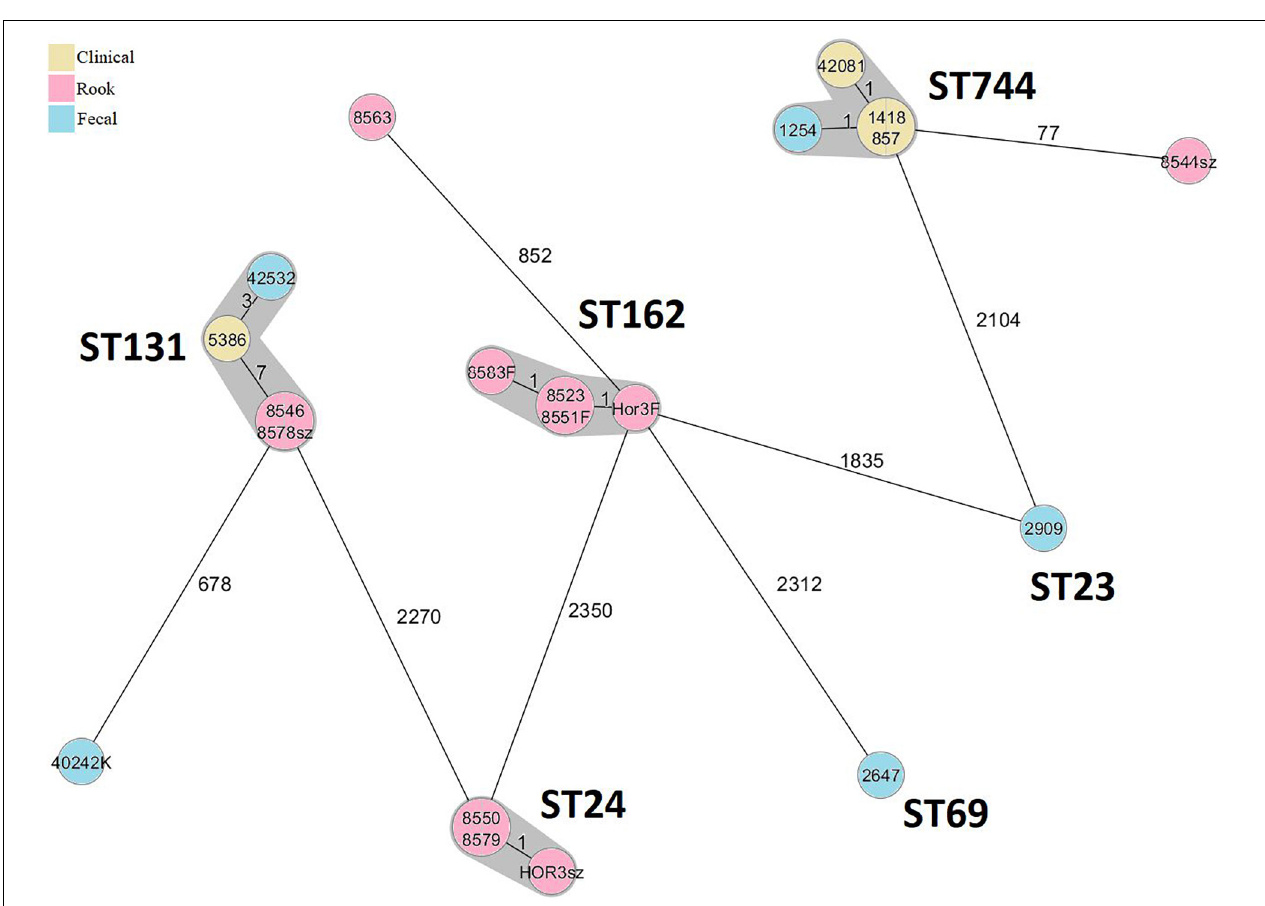
FIGURE 1 | Minimum spanning tree based on cgMLST allelic profiles of 20 sequenced E. coli isolates. Each circle represents an allelic profile based on sequence analysis of 2,513 cgMLST target genes. The numbers on the connecting lines illustrate the numbers of target genes with different alleles. Closely related genotypes ( < 10 alleles difference) are